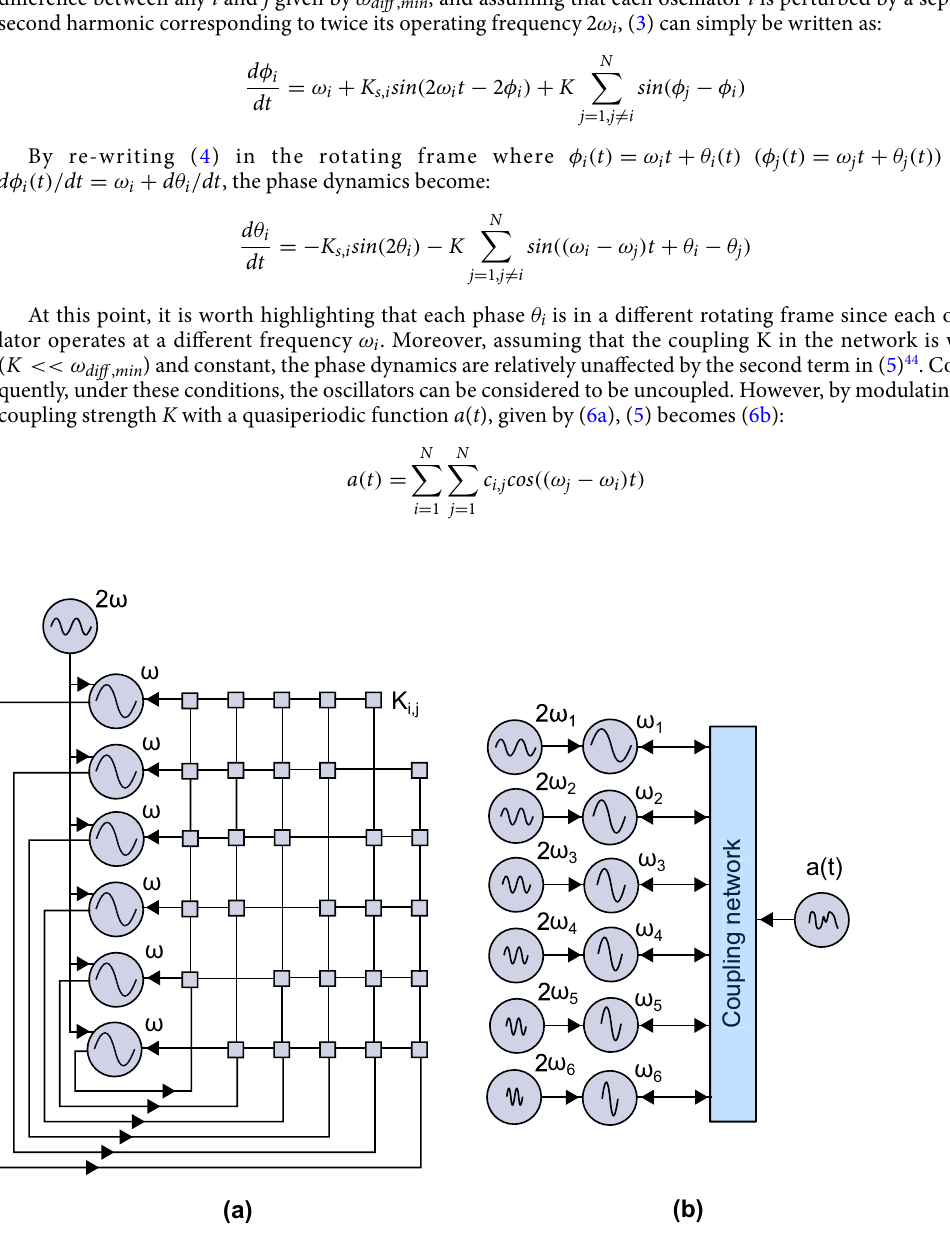
Figure 2. ( a ) A conventional oscillator-based IM requiring all-to-all coupling and ( b ) proposed implementation using a common